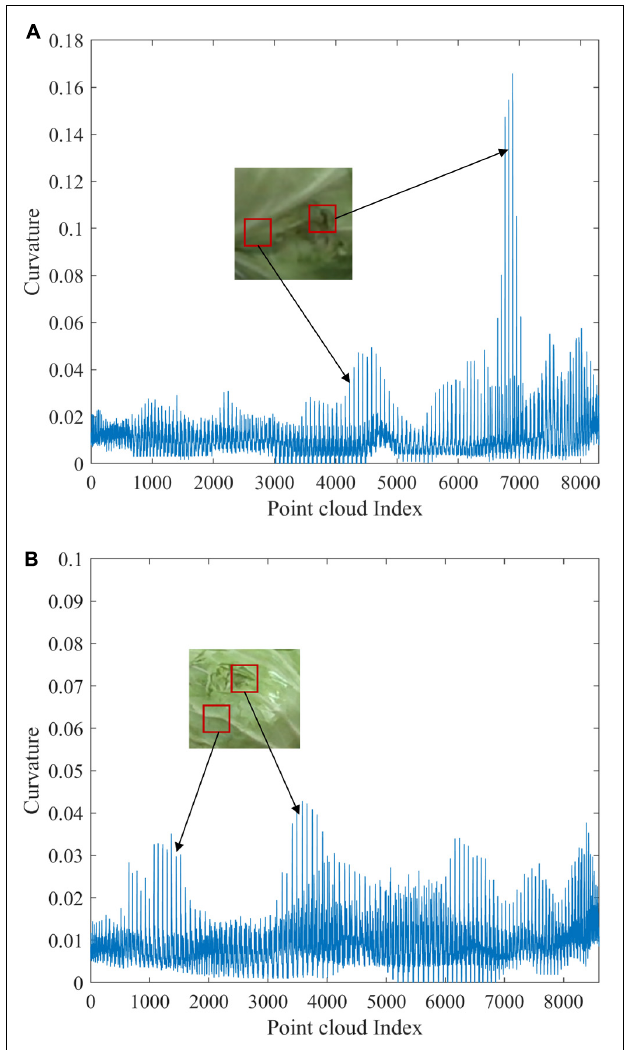
FIGURE 10 | Curvature curves of dent detection of cabbage: (A) the curvature curve of a correctly detected dent sample and (B) the curvature curve of a dent sample misjudged as non-maging.